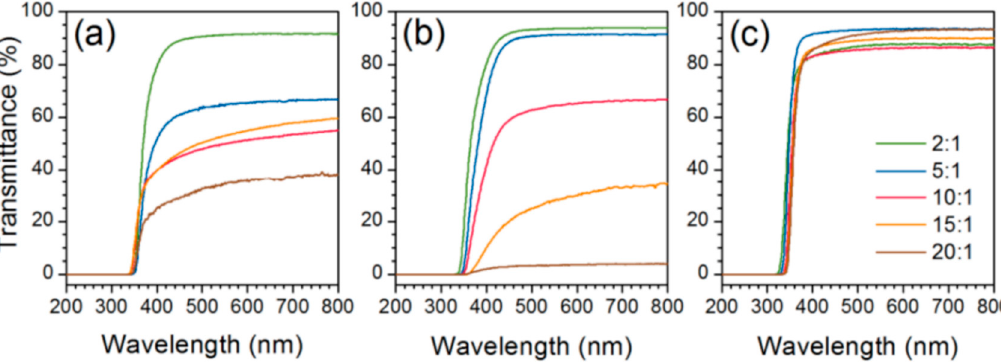
Figure 15. UV-VIS spectra of PDMS–TiO 2 hybrid films for different TIP/PDMS–OH molar ratios (shown in the legend), using PDMS–OH precursors with viscosities of ( a ) 25; ( b ) 65; and ( c ) 750 cSt, corresponding to average molar masses of 2100, 4000, and 20,000 g mol − 1 , respectively (calculated based on experimental measurements from [85]). Reproduced with permission from Dalod et al. Nanomaterials ; published by MDPI, 2017.